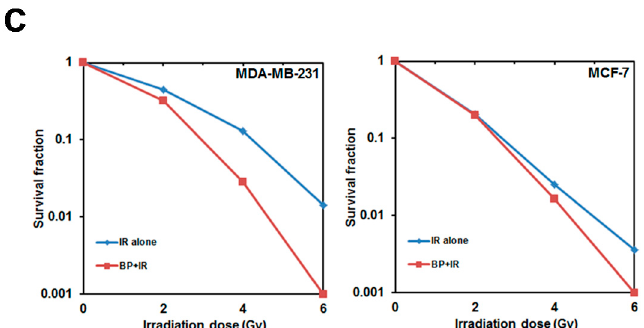
Figure 4. Effect of BP and/or IR treatment on the clonogenic survival of human breast cancer cells. ( A ) Human breast cancer cells were treated in the presence or absence of BP for 24 h and then exposed with or without IR (6 Gy). After 24 h, the cell survival rate was evaluated with the MTT assay; ( B ) Human breast cancer cells were treated in the presence or absence of BP for 24 h and were then exposed to IR (2 to 6 Gy). After 14 days, colonies with cells greater than 50 were stained with 2% crystal violet and counted; ( C ) The number of colonies was counted and the surviving fraction was normalized to the corresponding control by the survival curve analysis. The values are the mean ± S.D. from three independent experiments, * p < 0.05 vs. vehicle.